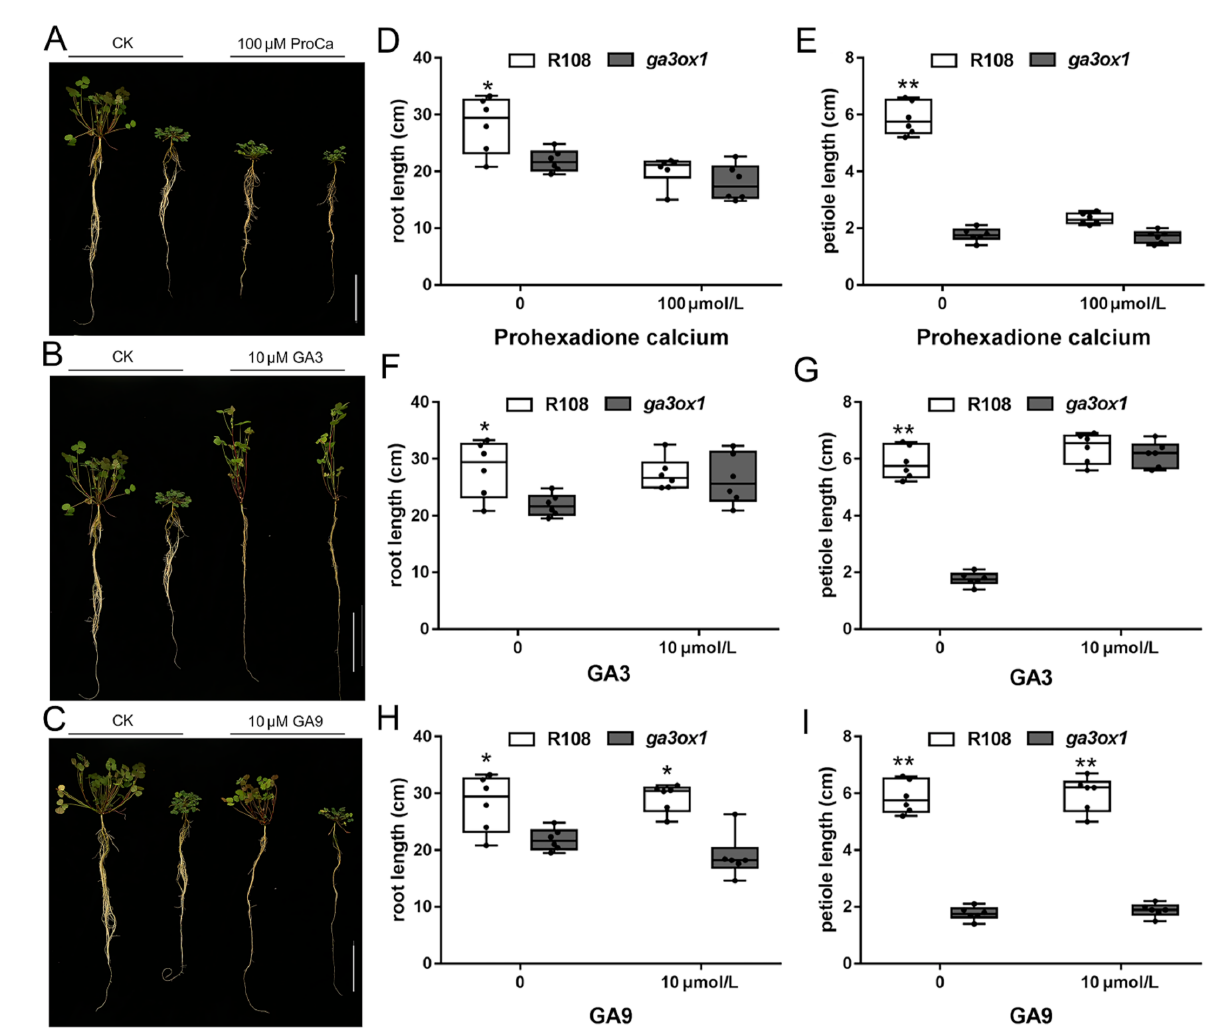
Figure 3. The dwarfism of ga3ox1 mutants resulted from bioactive GA deficiency. ( A – C ) Phenotype identification of wild-type R108 and ga3ox1 mutants treated with GAs and MtGA3ox1 enzyme inhibitors; note: control group (R108, ga3ox1 ) and treatment group (R108, ga3ox1 ) from left to right. ( D – I ) Root length and petiole length of wild-type R108 and ga3ox1 mutants treated with ( D , E ) 100 µ M prohexadione calcium, ( F , G ) 10 µ M GA 3 , ( H , I ) 10 µ M GA 9 . Six biological replicates were analyzed, and error bar indicates SD. Bars = 10 cm. * p < 0.05, and ** p < 0.01 by Duncan